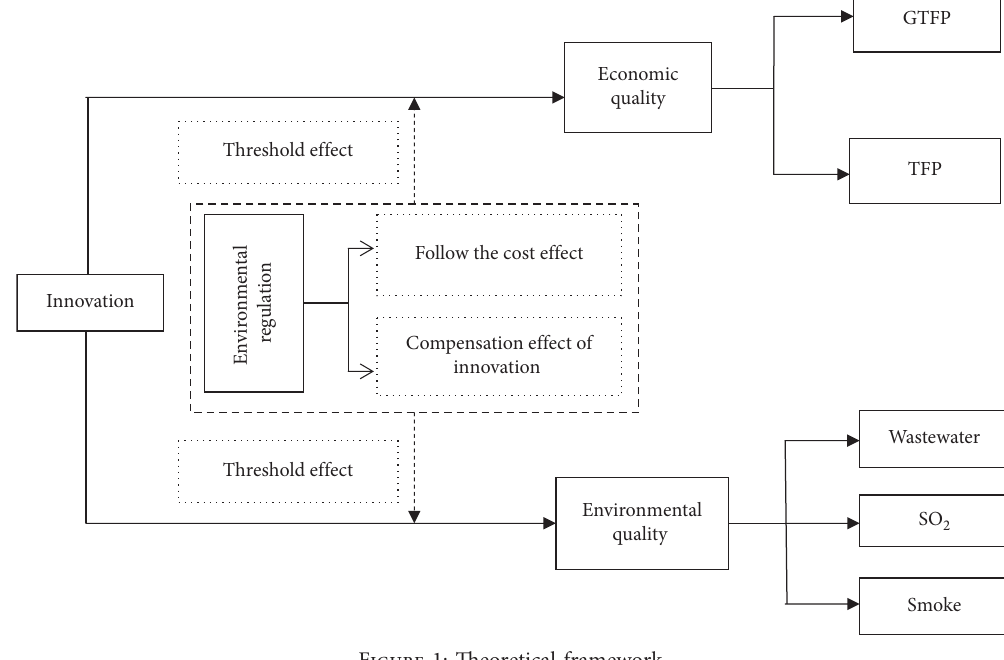
Figure 1: Theoretical